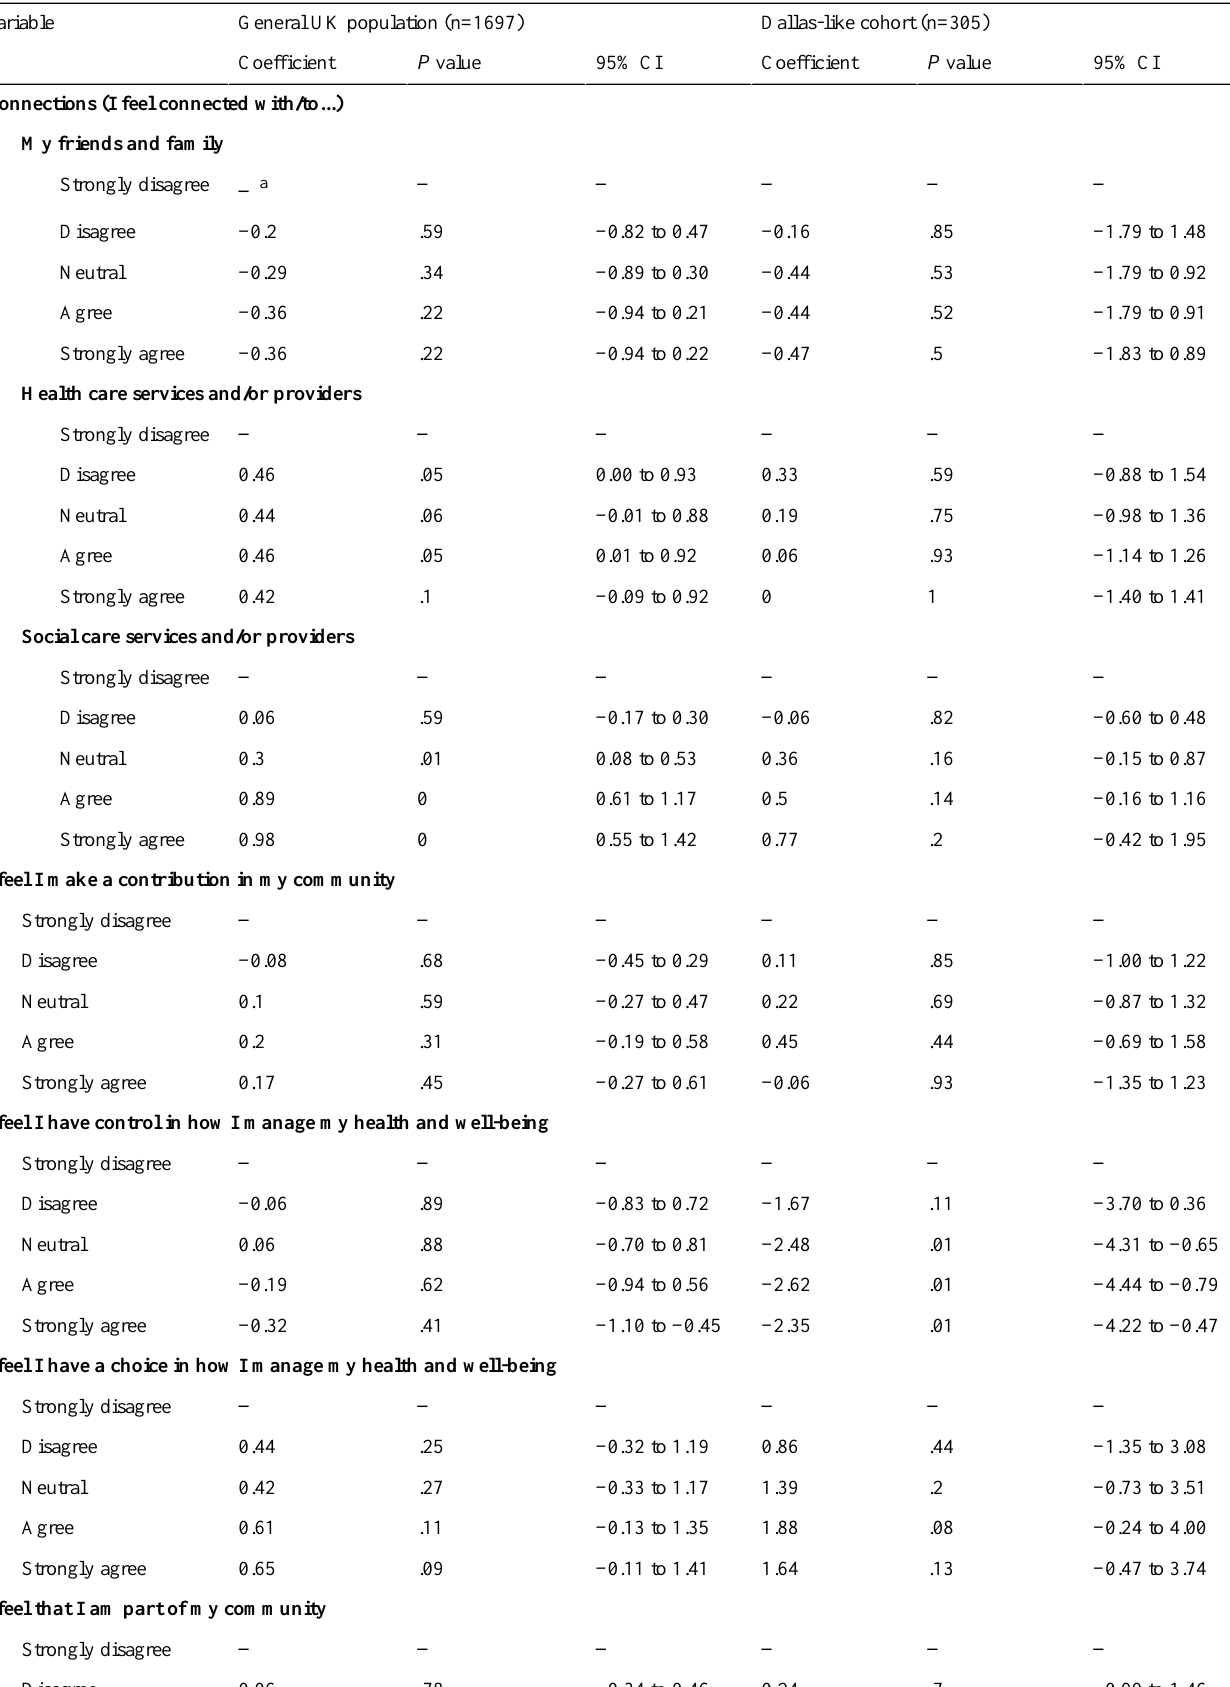
Table 3. Linear regression results for marginal willingness-to-pay and respondents’ current 6Cs levels (adjusted for age, total household income, and